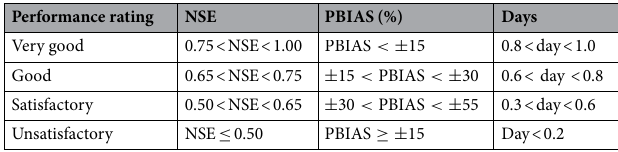
Table 5. General performance rating for model evaluation statistics.